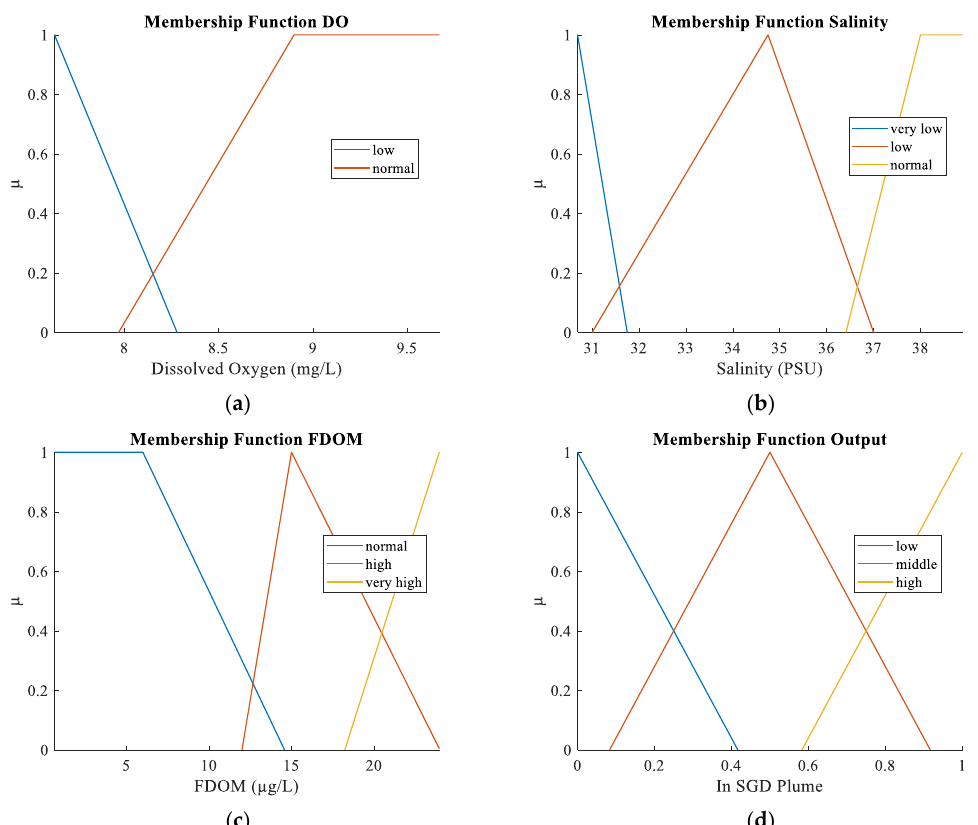
Figure 9. Fuzzy logic membership functions of the three input parameters ( a ) DO, ( b ) salinity, ( c ) FDOM, and ( d ) output used for SGD detection.